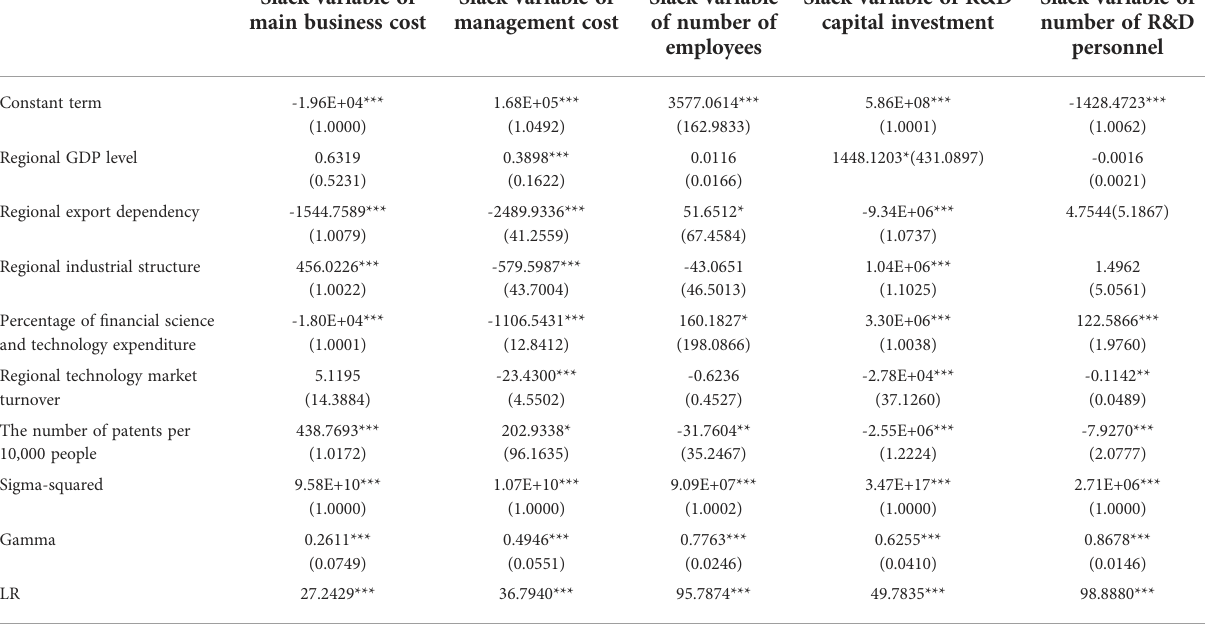
TABLE 5 SFA regression